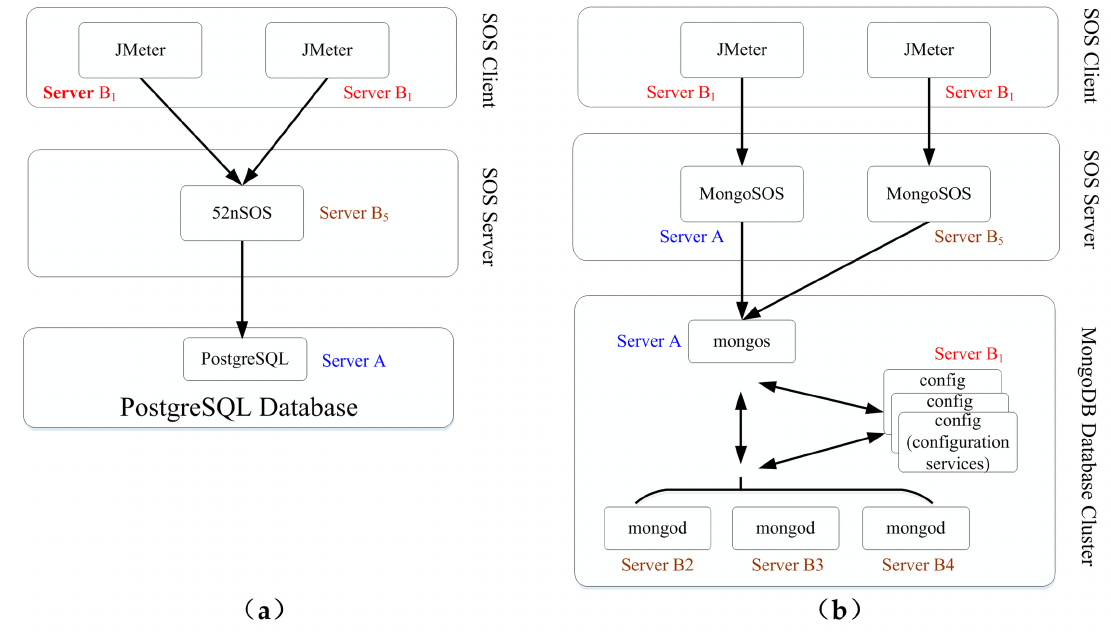
Figure 7. Test environment deployment architecture: ( a ) the 52nSOS deployment instance; and ( b ) the MongoSOS deployment instance.